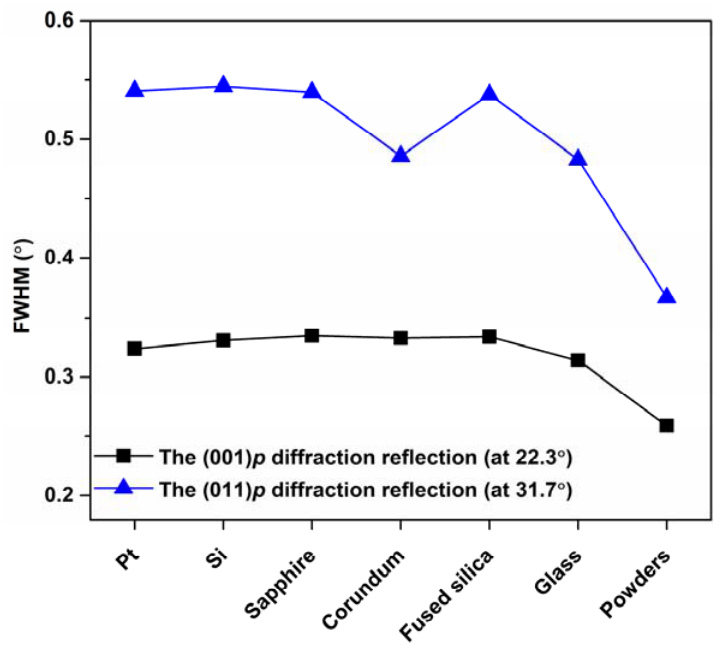
Figure 5. FWHM of the (001) p and (011) p reflections for the films fabricated on different